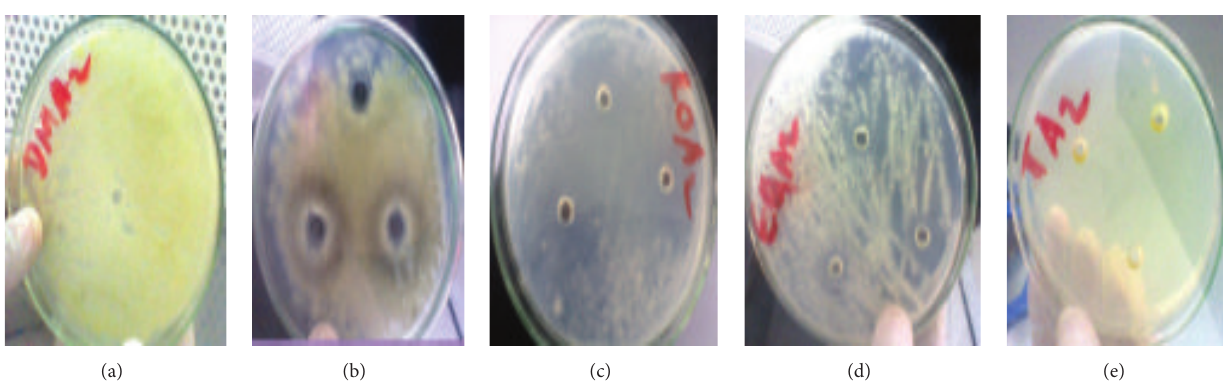
Figure5:Growthinhibitionzoneon Aspergillus spp2((a)=DMSO,(b)= Matricariachamomilla ,(c)= Rosmarinusofficinalis ,(d)= Eucalyptus globulus , and (e) = Thymus schimperi